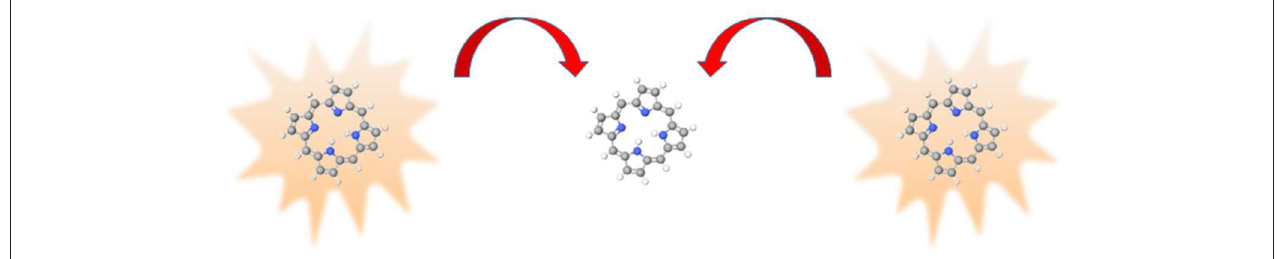
FIGURE 5 | Representation of energy pooling, the two excited donors (on the left- and right-hand side) transfer energy, represented by the red arrows, to the acceptor (in the center).